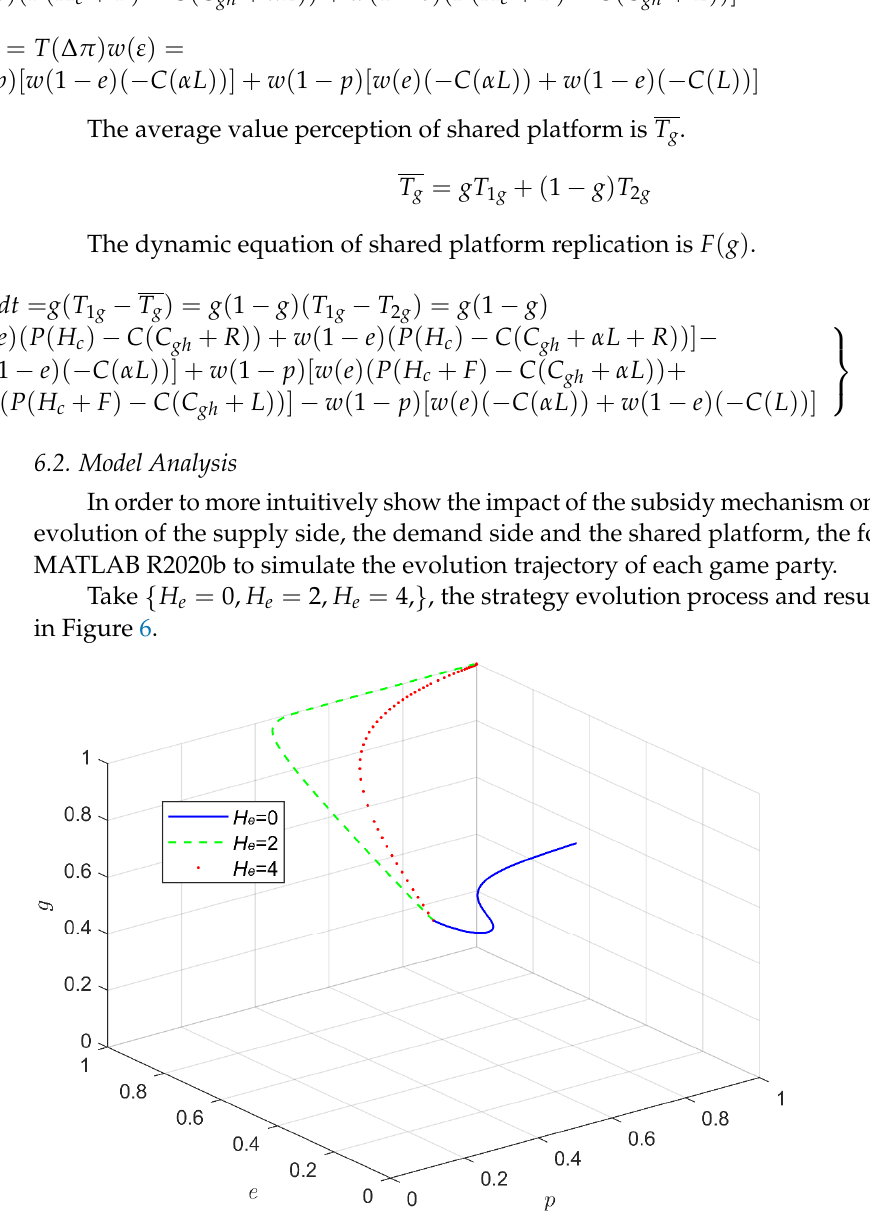
Figure 6. The impact of the subsidy mechanism on the evolution of the